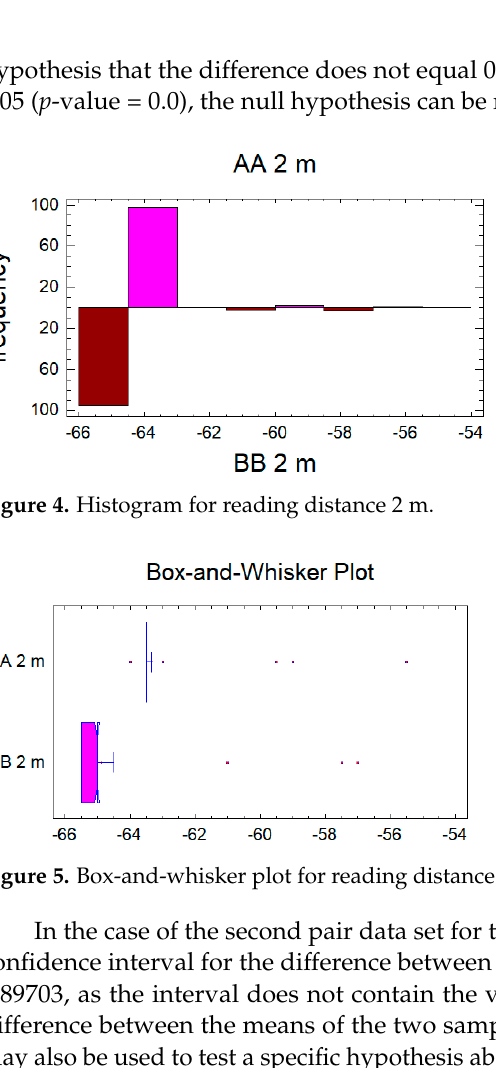
Figure 7. Box-and-whisker plot for reading distance 4 m. In the case of the third pair data set for the distance of 6 m, see Figures 8 and 9, the confidence interval for the difference between the means, which extends from 4.23891 to 4.54109, as the interval does not contain the value 0.0, there is a statistically significant difference between the means of the two samples at the 95.0% confidence level. A t -test may also be used to test a specific hypothesis about the difference between the means of the populations from which the two samples come. In this case, the test has been con- structed to determine whether the difference between the two means equals 0.0 versus the alternative hypothesis that the difference does not equal 0.0. Since the computed p -value is again less than 0.05 ( p -value = 0.0), the null hypothesis can be rejected in favor of the alternative. Figure 8. Histogram for reading distance 6 m.